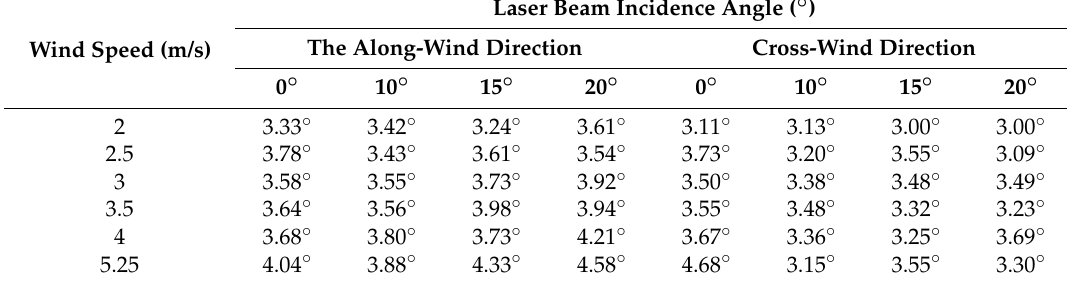
Table 4. Refraction angle standard deviations (2 σ ) in the along-wind and cross-wind directions as obtained from empirical measurements for a laser beam diameter of 0.25